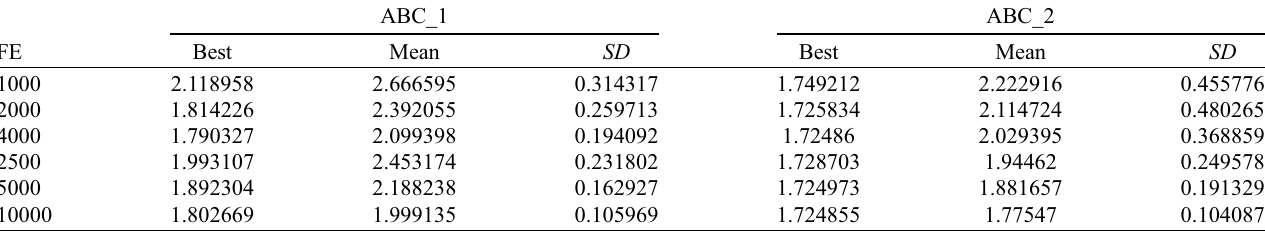
Table 2. Comparison of different variants of ABC algorithm for Example 1 (welded beam) with different function evaluations for the best solutions obtained in 100 runs.